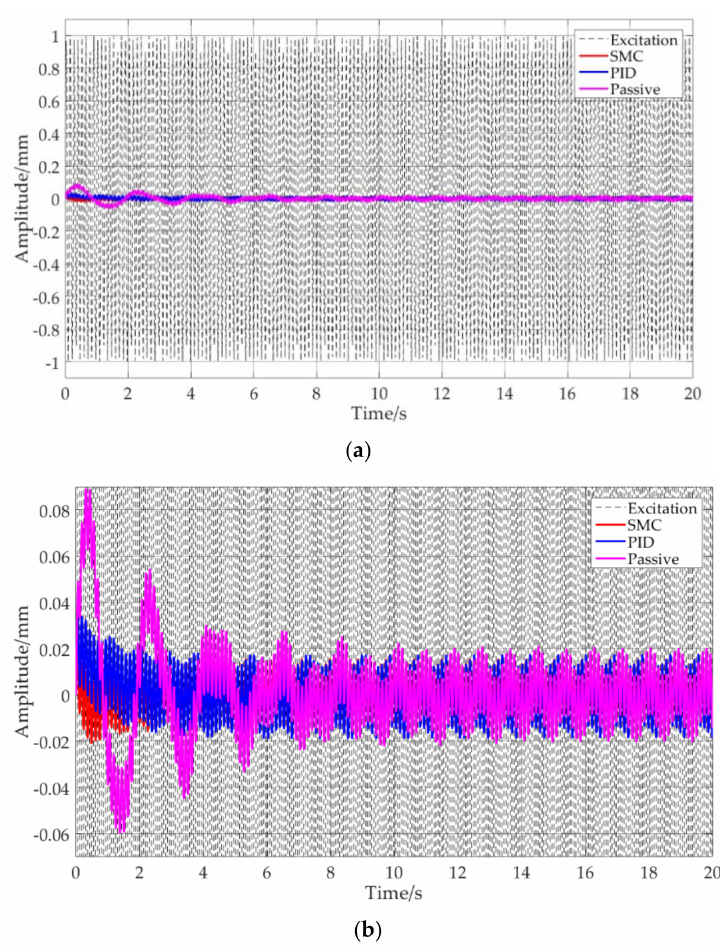
Figure 9. Comparison of the SMC. PID and the passive system under excitation of a sinusoidal signal with an amplitude of 1 mm and a frequency of 50 rad/s ( a ) full figure ( b ) partial enlarged